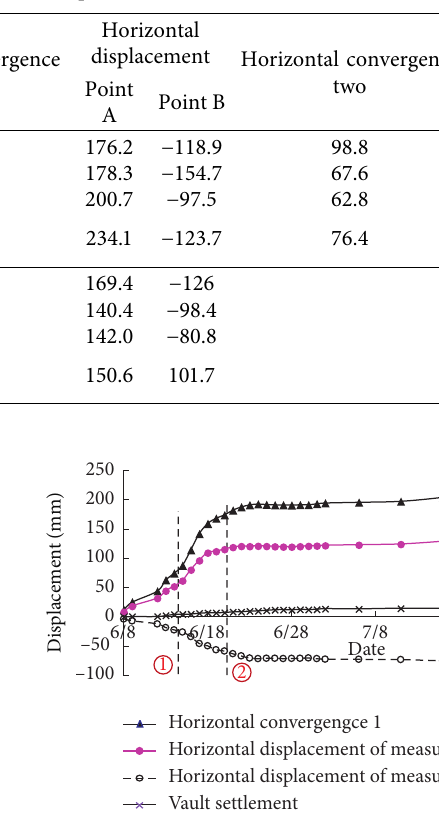
Figure 8: Time-history curves of tunnel deformation in the third test section (DIK77 +548).